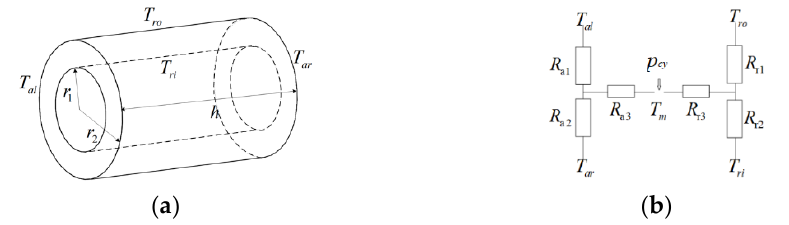
Figure 3. Hollow cylinder heat conduction model: ( a ) Hollow cylinder structure; ( b ) Equivalent thermal network model.